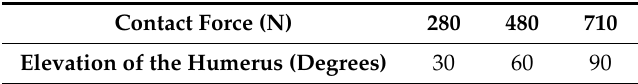
Table 2. Applied force to the glenosphere as a function of the elevation angle of the humerus in the case of individual 1.